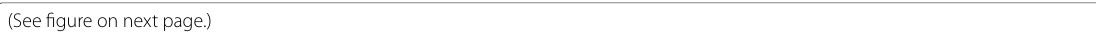
(See figure on next page.) Fig. 8 Image of the estimated rotation axes and observed target positions for the inside method. a Az axis and target positions. Red-colored vertical line stands for the estimated Az axis. Red dots represent the observed target positions. Red-colored circles represent trajectory of the target positions, used for the estimate of the Az axis; b El axes and target positions. Blue and light blue-colored horizontal lines stand for the estimated El axes. Blue and light blue-colored dots and circles represent the observed target positions and trajectory of the target positions,